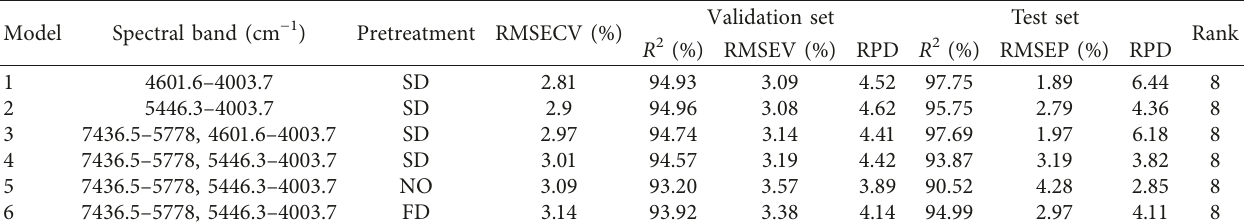
Table 3: NIR models for determining ZnO content in calcined